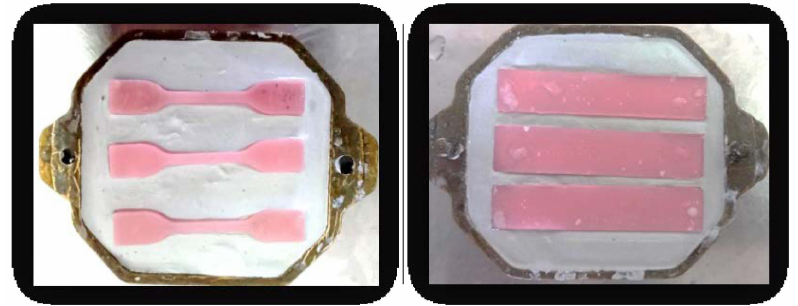
Figure 2. Investing wax pattern and mold realization.